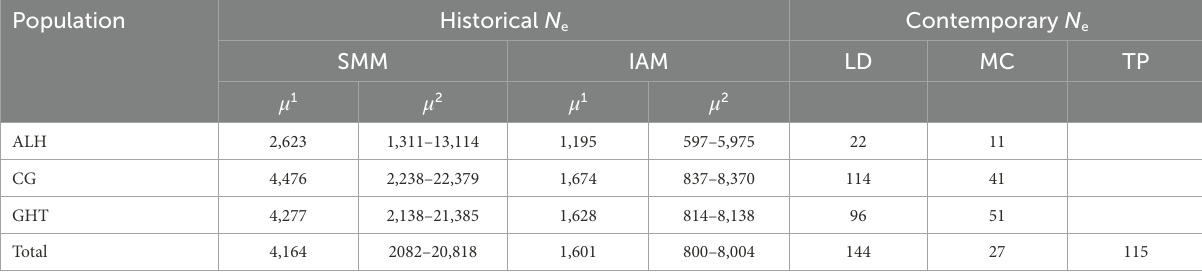
TABLE 4 Estimation of demographic parameters using different methods and mutation models.